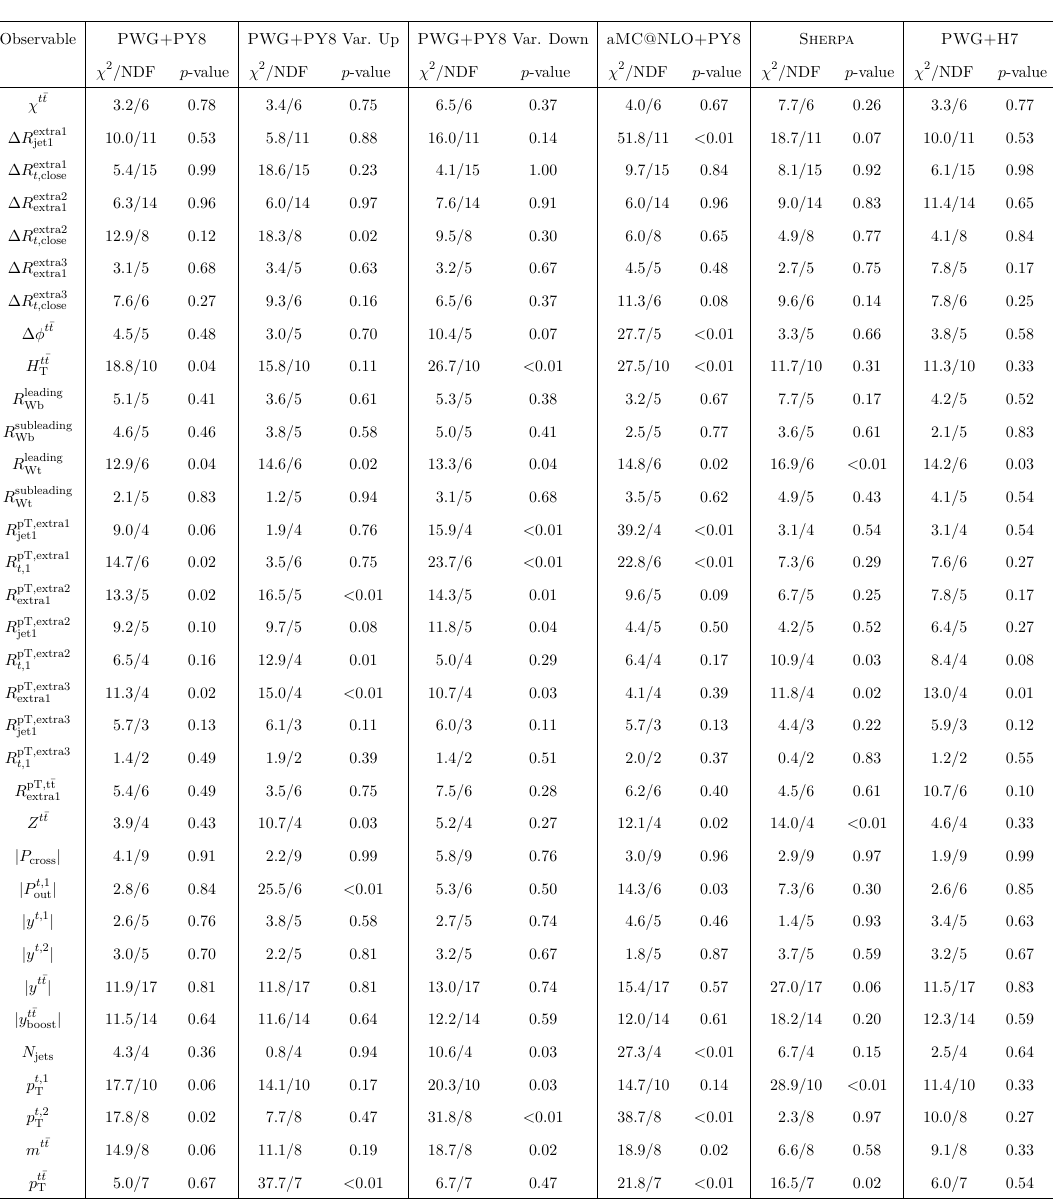
Table 9 . Comparison of the measured particle-level normalised single-differential cross-sections with the predictions from several MC generators. For each prediction, a χ 2 and a p -value are calculated using the covariance matrix of the measured spectrum. The number of degrees of freedom (NDF) is equal to the number of bins in the distribution minus